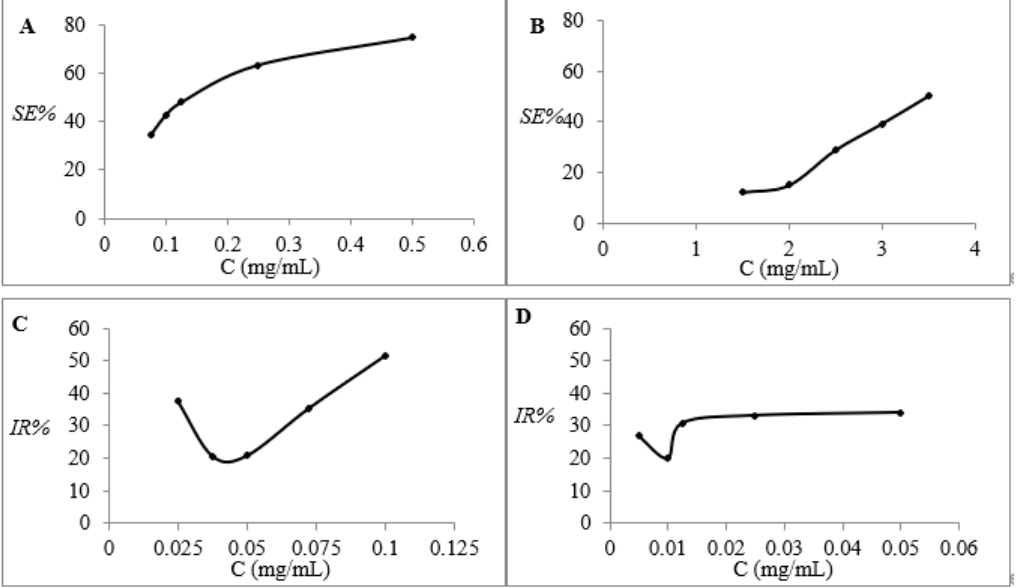
Figure 5. Antioxidant effects of five different concentrations of TMPZ. ( A ) Scavenging effect on DPPH. ( B ) Scavenging effect on H 2 O 2 . ( C ) Inhibiting rate on MDA production in liver homogenate. ( D ) Inhibiting rate on MDA production in low density lipoprotein.